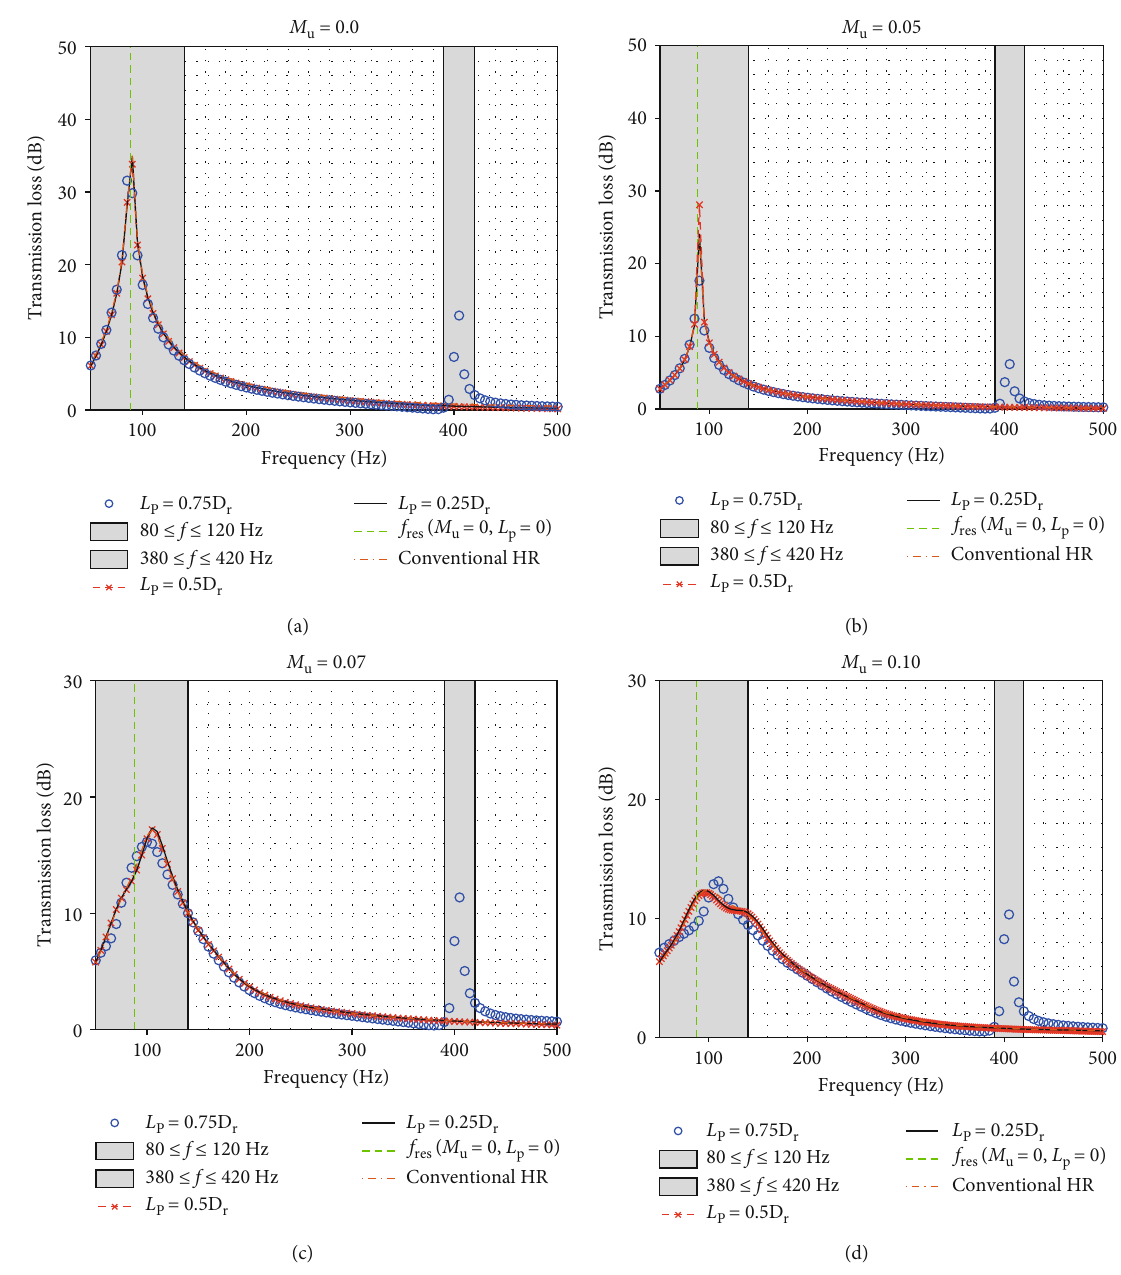
Figure 6: Variation of the transmission loss with forcing frequency, as the rigid ba ffl e is attached at H / D = 0 : 25 , L / D = 0 : 5 , and L L p r p r